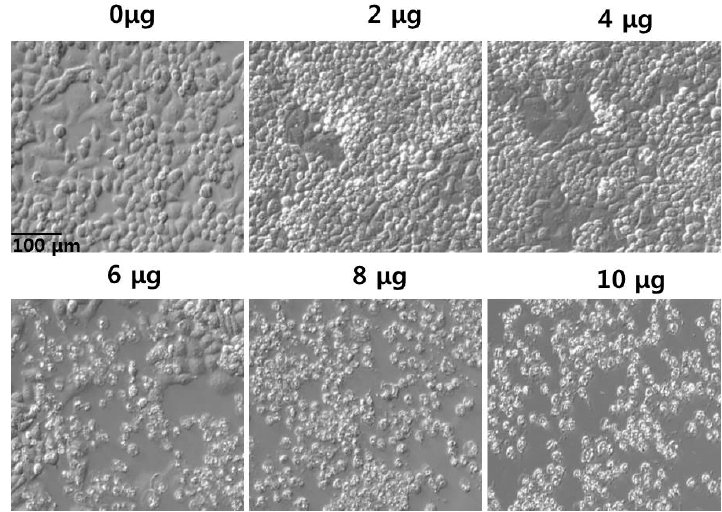
Figure 7. Morphology of human ovarian cancer cells treated with palladium nanoparticles (PdNPs) Morphology of A2780 cells treated with various concentrations of PdNPs (0–10 µ g/mL) for 24 h. Images were recorded using interference contrast light microscopy.